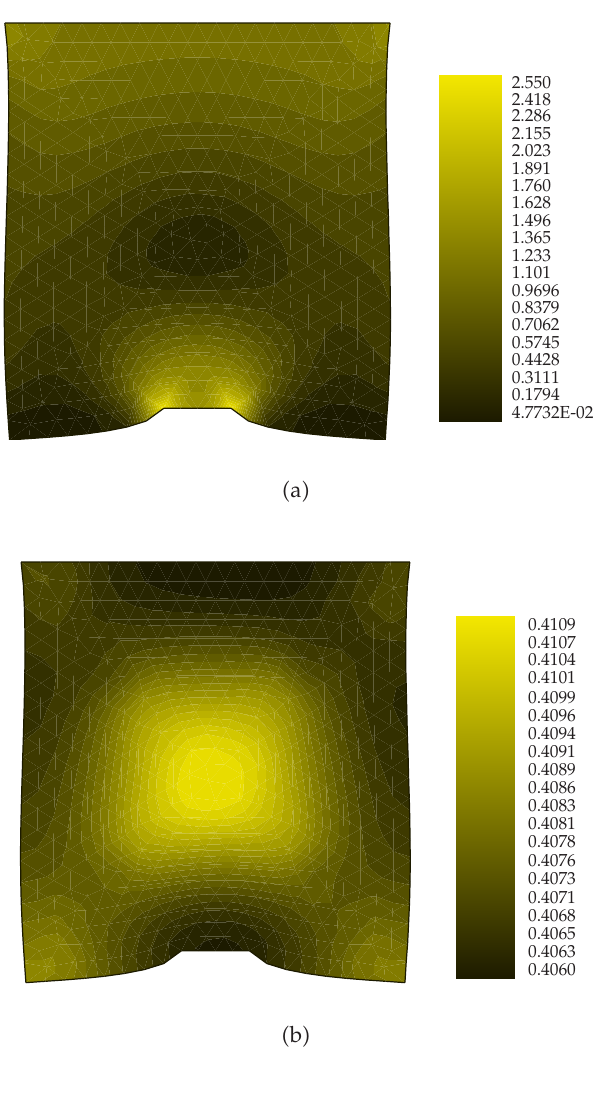
Figure 4.7 . Von Mises stress norm and damage field at final time in the deformed